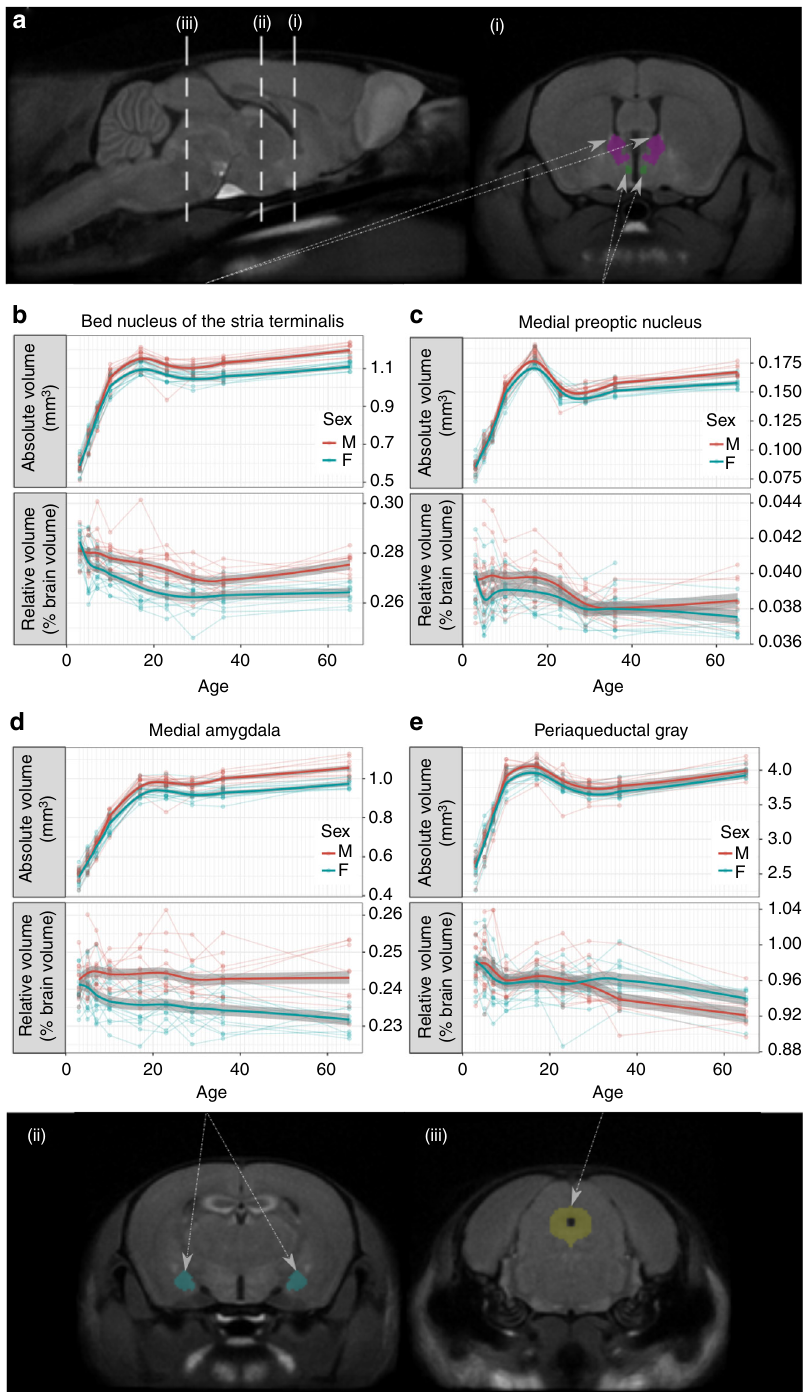
Fig. 3 MEMRI captures sex differences in brain structure sizes. a Sagittal and coronal slices of the average p65 brain showing segmentations of mouse brain structures: bed nucleus of the stria terminalis (BNST), medial preoptic nucleus (MPON), medial nucleus of the amygdala (MeA), and periaqueductal gray (PAG). b – e the absolute and relative volumes of these structures over time. Points in these plots represent measurement at a time point for individual mice and lines connect the measurements for the same mouse over time. Shaded regions represent standard error estimated using linear mixed-effects models. Relative volume corrects for whole-brain size differences between subjects and is expressed as a percent difference from the average volume of the brain structure. Using linear mixed-effects models, we recapitulate known canonical sex differences in absolute volumes of the MeA ( χ 2 66, P <10 9 ¼ − 10 ), BNST ( χ 2 77, P <10 − 12 ), and MPON ( χ 2 28, P <10 − 3 ). Sex differences in these structures emerge pre-puberty, at around p10. Using relative 9 ¼ 9 ¼ volumes to correct for whole brain size, we see that sex differences in these structures are preserved but differences emerge earlier in development around p5. PAG relative volume also shows a signi fi cant effect of interaction between sex and age ( χ 2 21, P <10 − 2 ), which is not found in the absolute volumes ( 8 ¼ χ